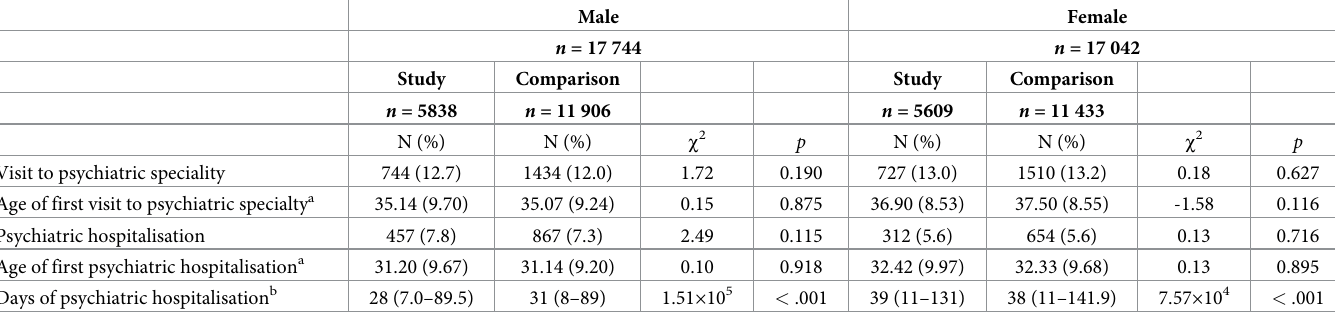
Table 3. Psychiatric care service use in study and comparison cohort in males and